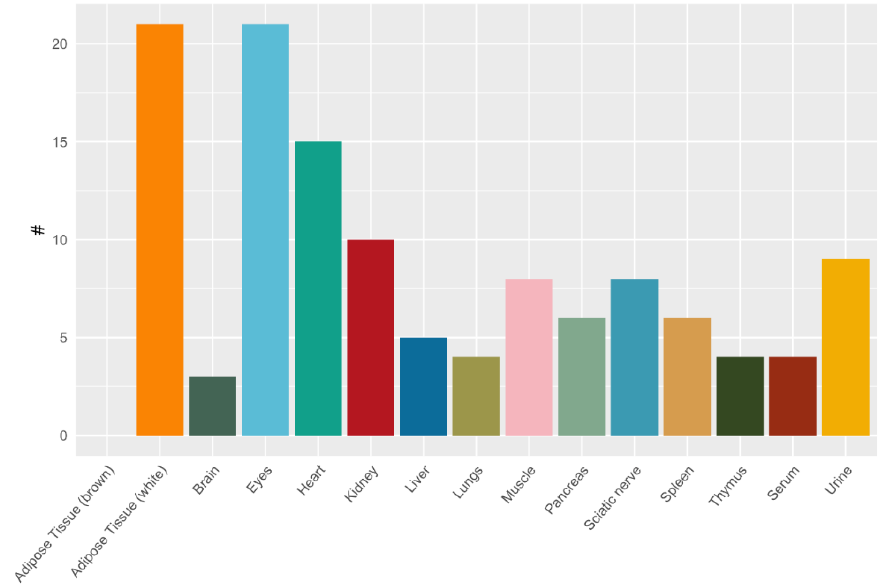
Figure 8. Correlation of dipeptides and respective amino acids in murine tissues and biofluids. Several tissue dipeptide concentrations correlated with the respective amino acid concentrations only when the amino acid was present at the C-terminus of the